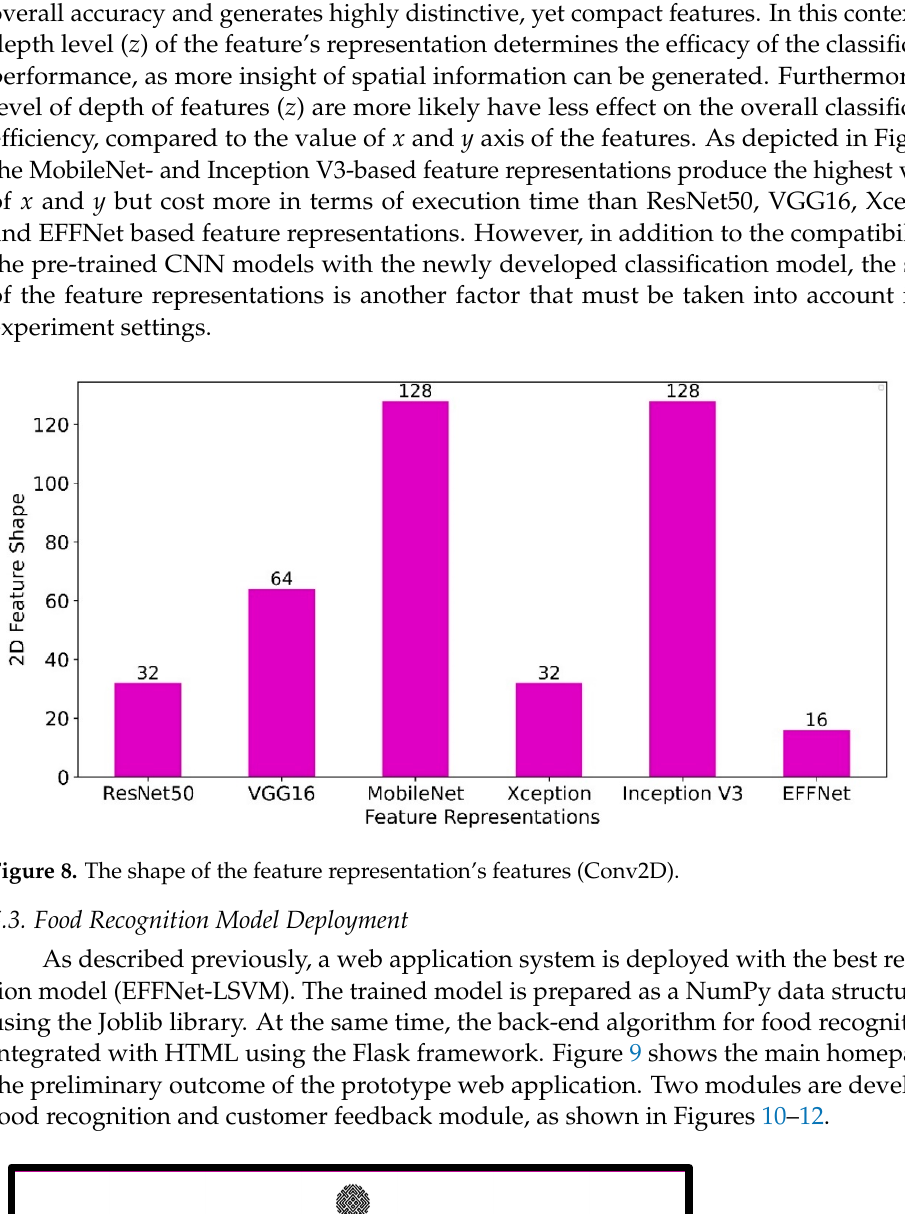
21 of 26 Table 25. A comparison of feature dimension and overall accuracy performance. Feature Representation